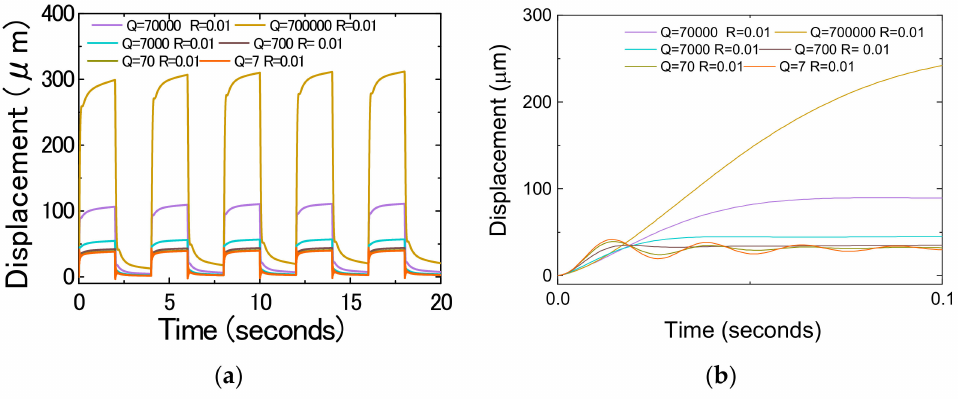
Figure 4. LQR simulation results comparison: ( a ) Varying Q; ( b ) close-up view of ( a ) for the first 100